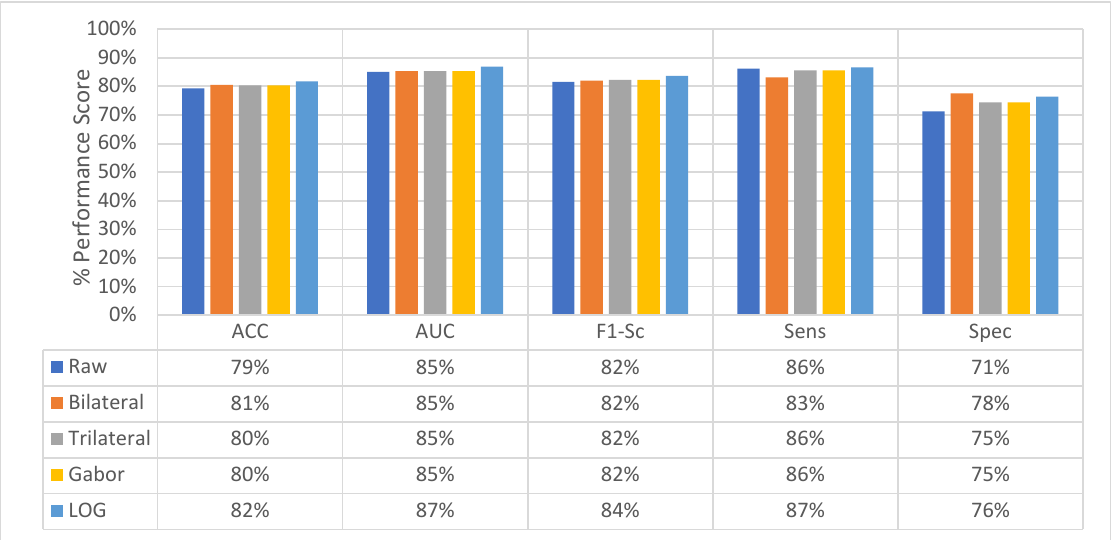
Figure 35. Change in average-perspective level classification performance of the proposed classifiers.